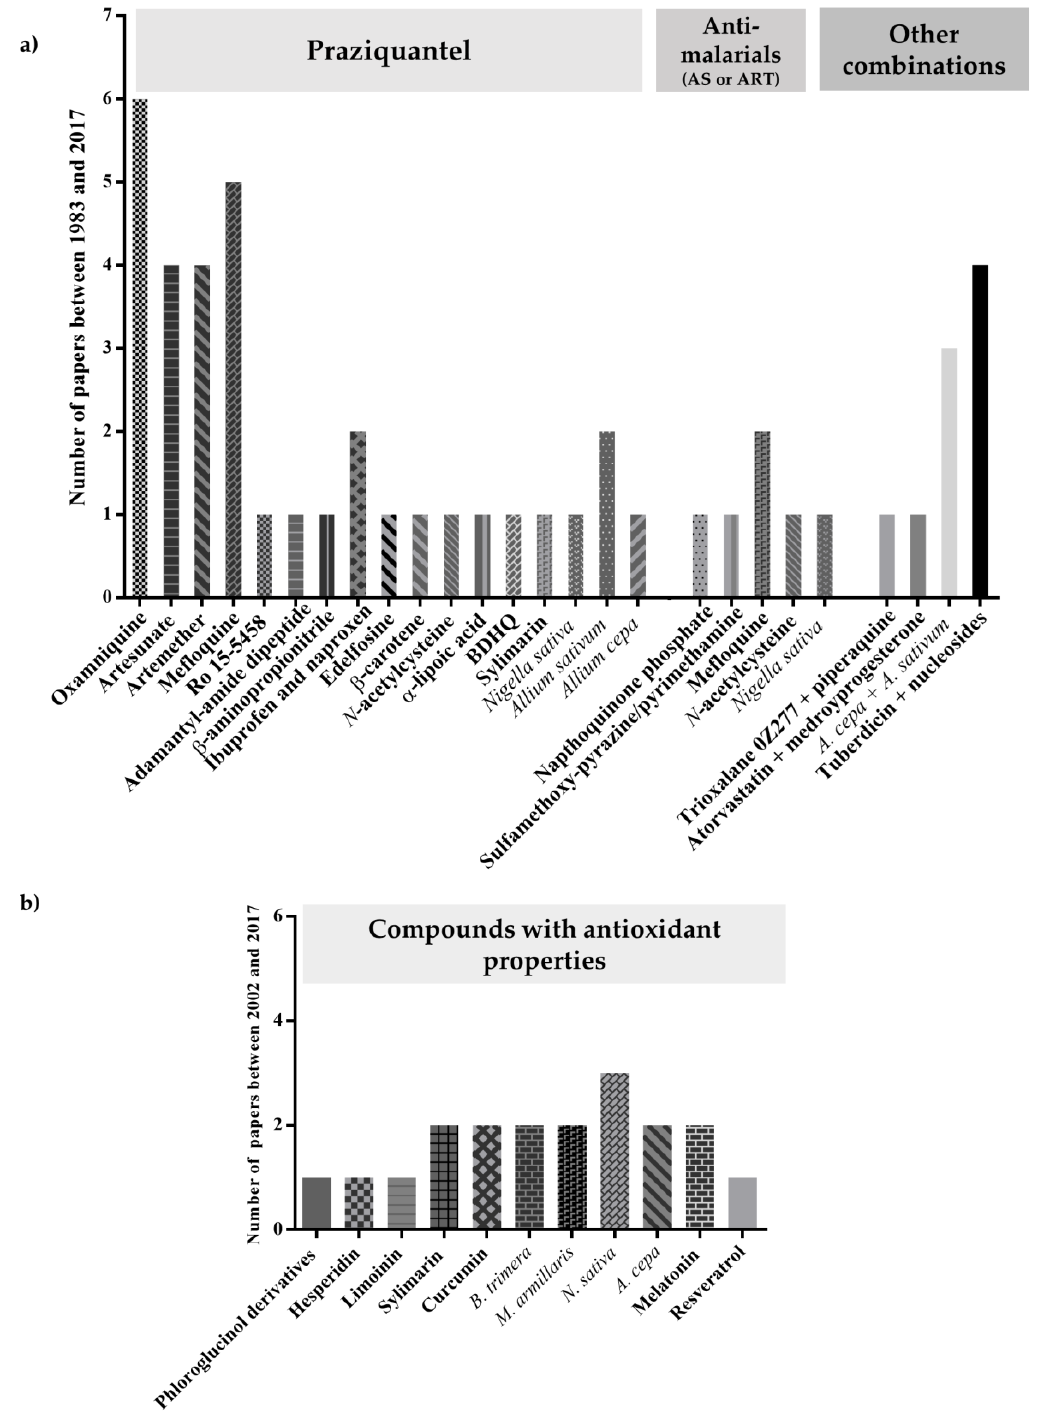
Figure 10. Graphical depiction of the number of publications dealing with ( a ) combinations between compounds with PZQ, antimalarials and other combinations; ( b ) compounds with antioxidants alone performed on both in vitro on in vivo cultured forms of schistosomes.